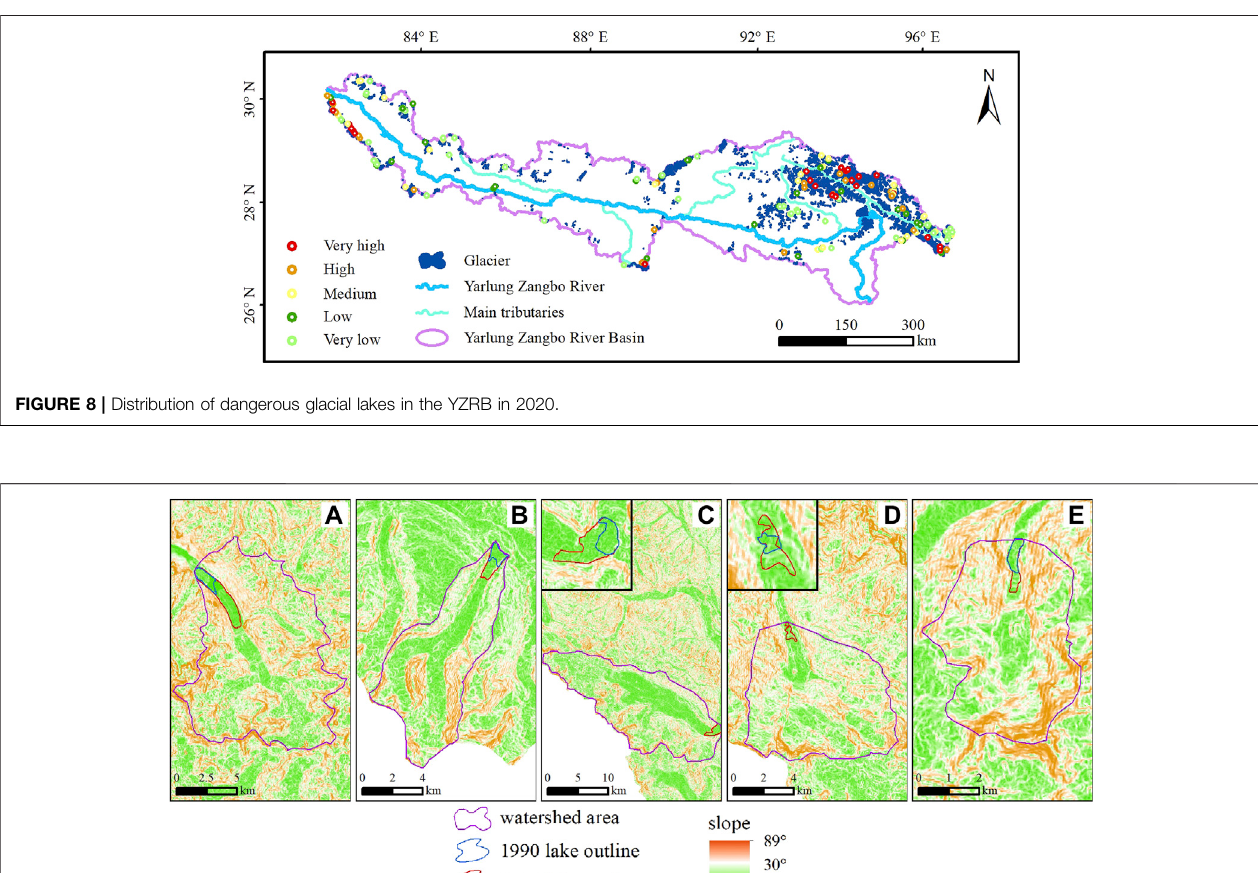
Frontiers in Earth Science |